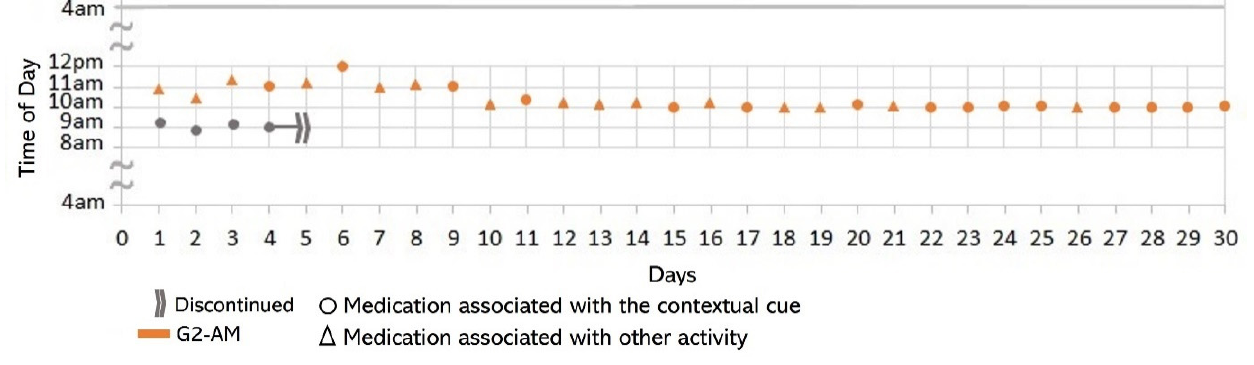
Figure 3. Medication behavior of S1 shows the time of day in which the group of medication (G2) was taken daily and whether G2 was associated with the activity set as the contextual cue.